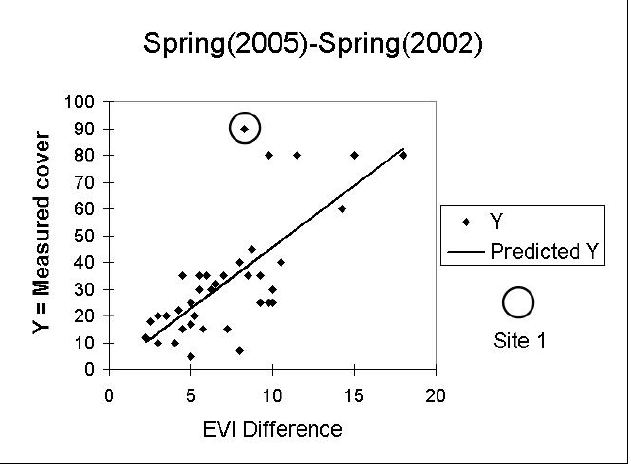
Figure 6. Scatter plot between field-estimated 2005 annual cover and the annual-growth model based on the metric Average Spring (2005)-Average Spring (2002). In spring 2005, site 1 had nearly 90% annual cover and, in contrast to other high-annual-cover sites that were dominated by forbs, it was composed of nearly all non-native Schismus . (Y= Annual Cover, measured in field and